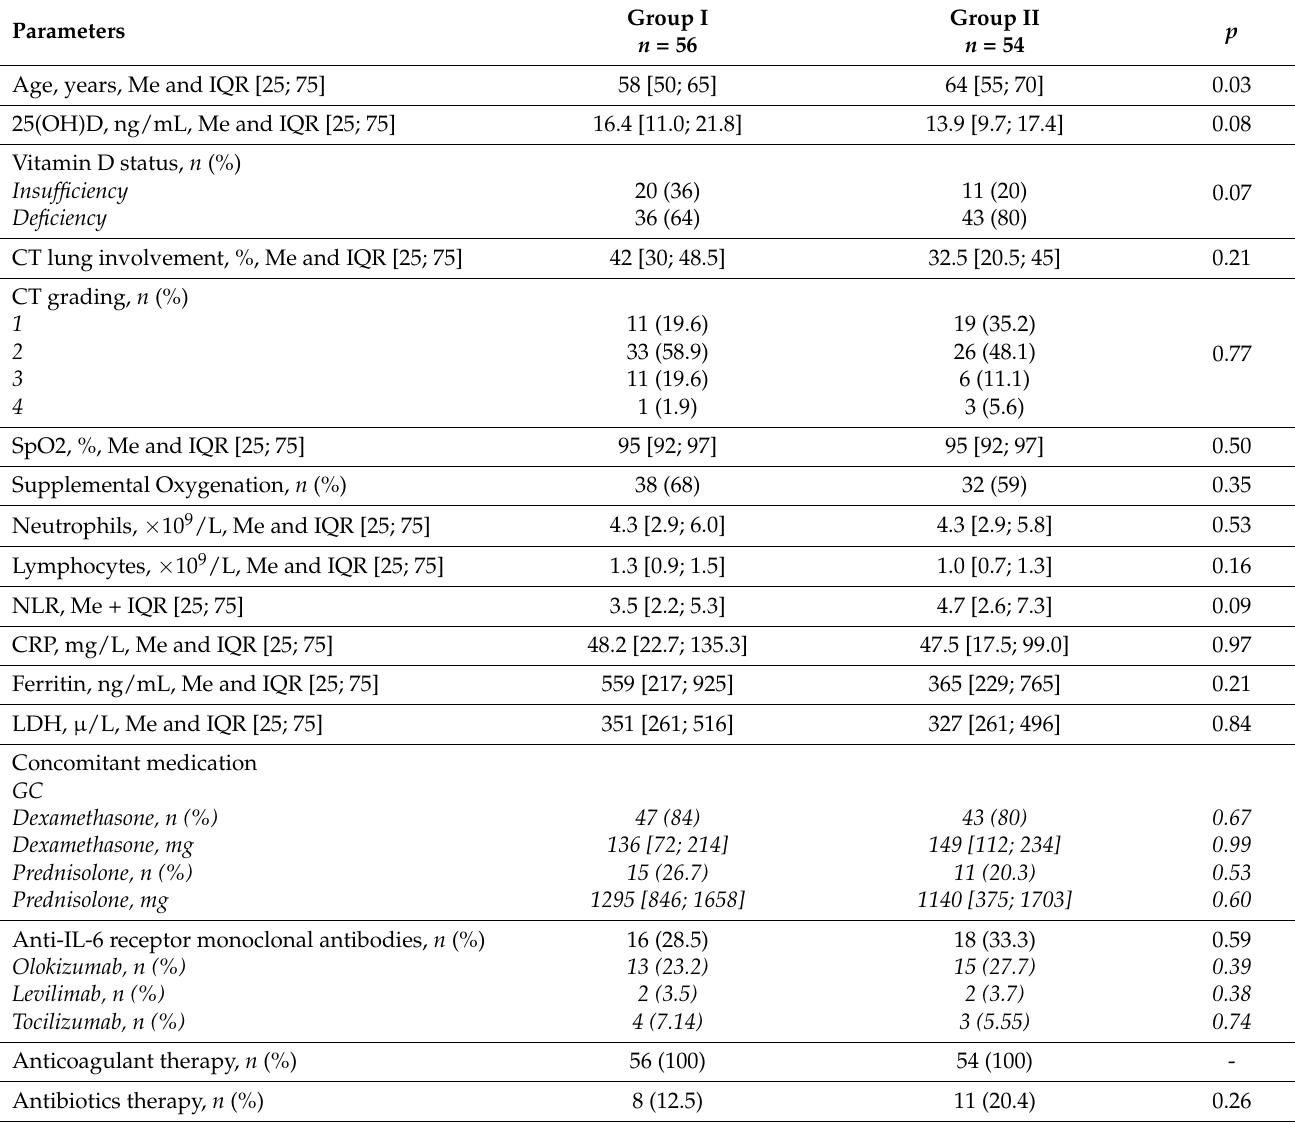
Table 2. Patients’ baseline characteristics with vitamin D insufficiency and deficiency ( n =